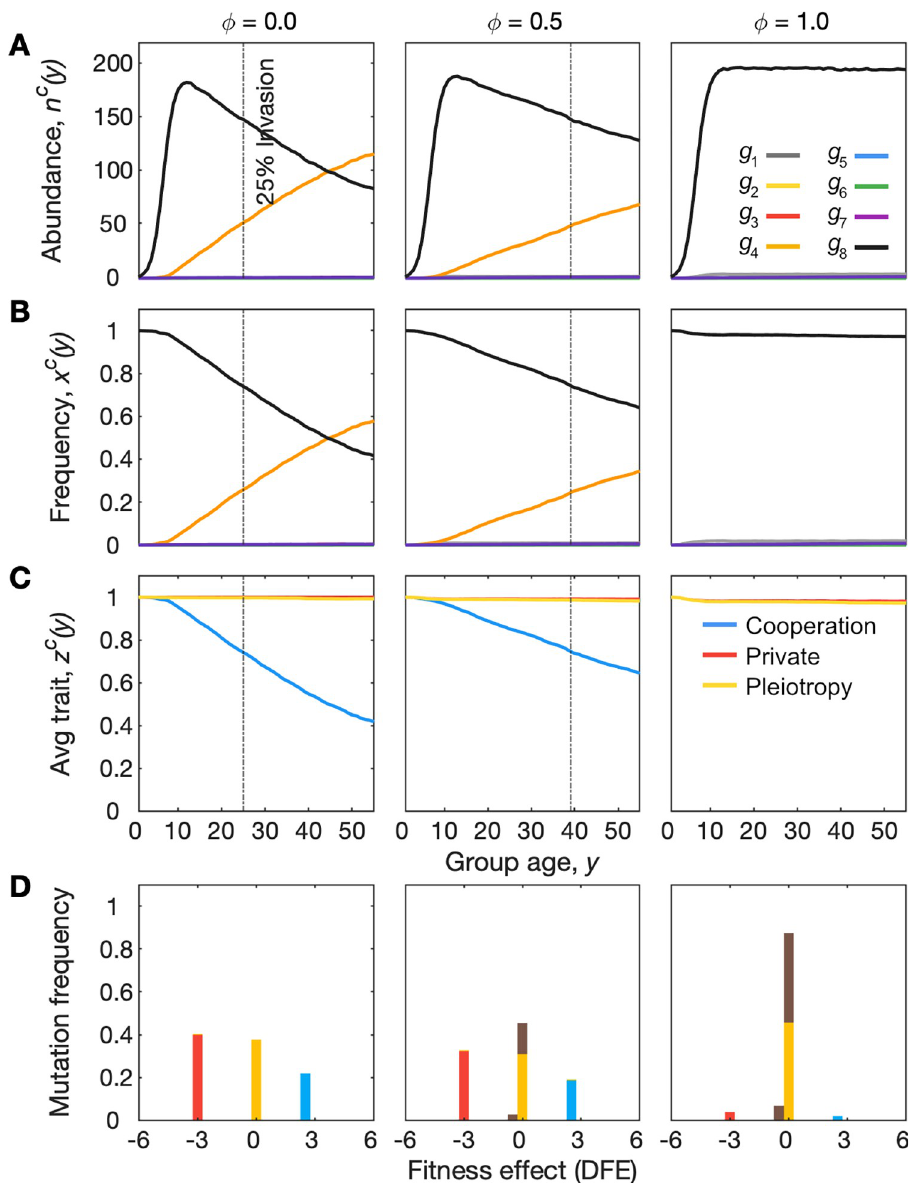
Fig 3. The evolution of cooperation within groups depends on the strength of pleiotropy ϕ . Within-group mutation selection dynamics are shown for a group founded by a cell with genotype g 8 , which actively expresses a cooperative trait, z c ¼ 1 , a private trait, z c ¼ 1 , and a pleiotropy trait, z c ¼ 1 . Growth of the group as its age, y , u v p increases, is logistic, with a carrying capacity K = 200 at which point cells continue to divide, die, and turnover (see Methods). Dynamics are shown from left to right for 3 different strengths of pleiotropy, ϕ , where pleiotropy is absent/ has no effect in the left-hand side column ( ϕ = 0). For comparison, the vertical dashed line in (A-C) shows the point at which noncooperative lineages shown in orange make up 25% of the group. Pleiotropy leads to this point being delayed ( ϕ = 0.5) or prevented ( ϕ = 1). (A) Changes in genotype abundances, n c ( y ). (B) Changes in genotype relative frequencies, x c ( y ). (C) Changes in the average levels of cooperation, private trait expression, and pleiotropy, z c ð y Þ . (D) Distribution of fitness effects: Shown is the effect on within-group fitness of the different types of loss-of-function mutations that occur, which are coloured by their phenotypic effect, where blue is loss of cooperative trait, red is loss of the private trait, yellow is loss of pleiotropy, and brown is loss of both cooperation and private trait (due to pleiotropy). When pleiotropy is weak or absent, loss-of-function mutations to cooperative traits increase the fitness of cells within the group, and loss-of-function mutations to private traits decrease the fitness of cells within the group. When the strength of pleiotropy is increased, mutations to either trait tend to have pleiotropic effects, which cancel one another out, meaning mutant cell lineages no longer gain an advantage within the group. Formally, the fitness effect